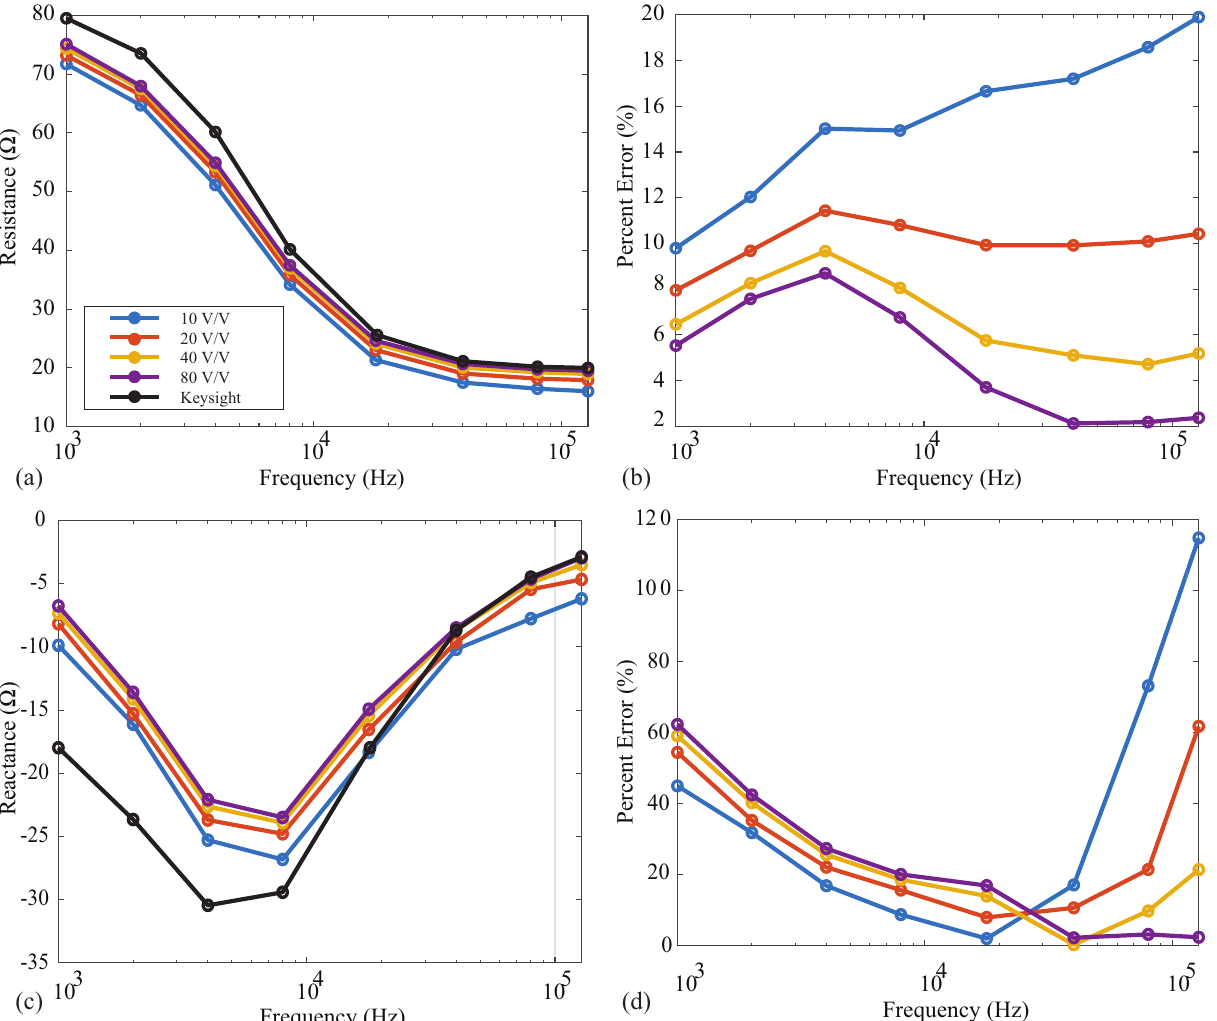
Figure 9. MAX3000x’s ( a ) resistance and reactance ( b ) measurements of 2 R − 1 C Model 1 and relative ( c ) resistance and ( d ) reactance errors (compared to the Keysight E4990A reference values) using PGA configurations of 10 v / v (blue), 20 v / v (red), 40 v / v (orange), and 80 v / v